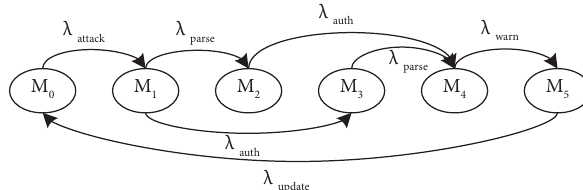
Figure 5: Markov chain of the SGIoT SPN